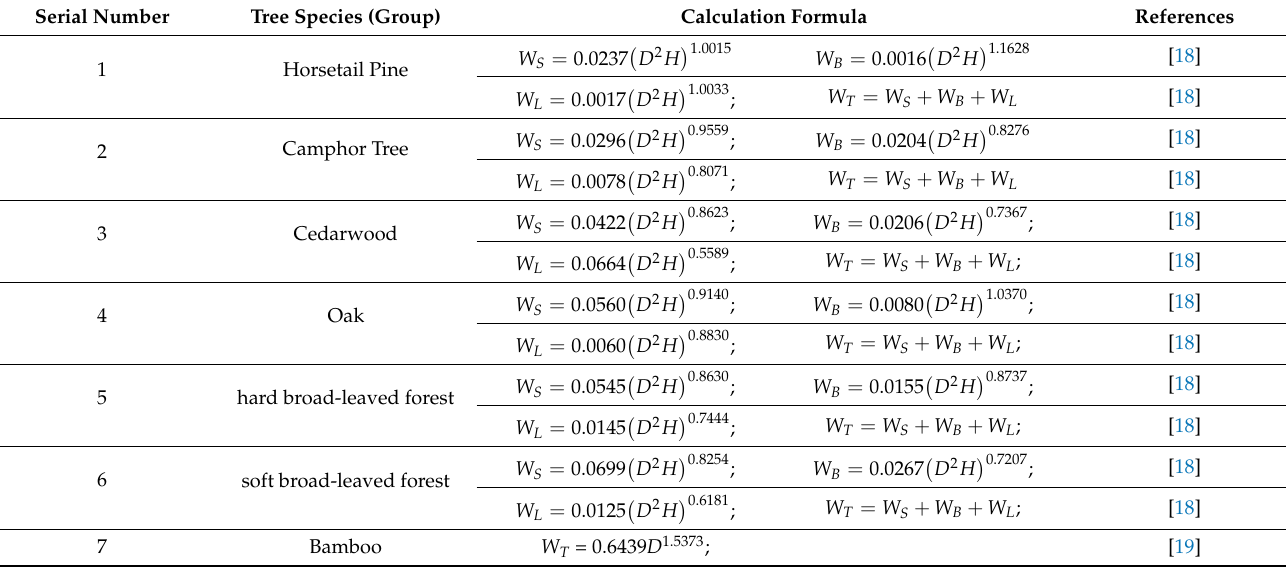
Table 2. Aboveground biomass calculation formula of different tree